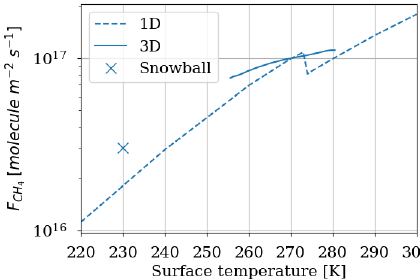
Figure 13. Temperature profile for a surface temperature of 280 and 260K. Results of the 3D model surface and annual average (solid) as well as the 1D model